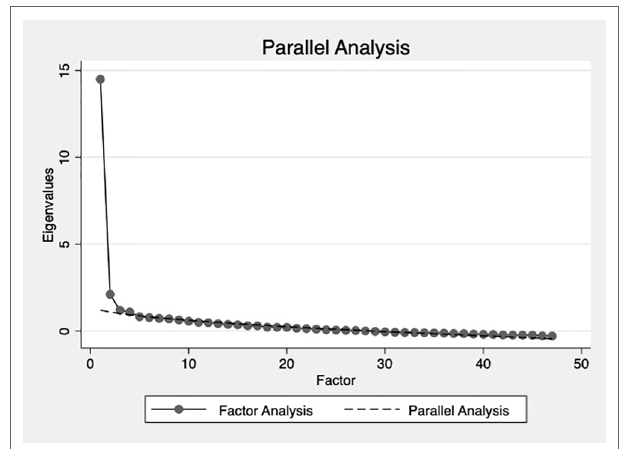
FIgURe 1 | Parallel analysis and Principle Axis Factoring scree